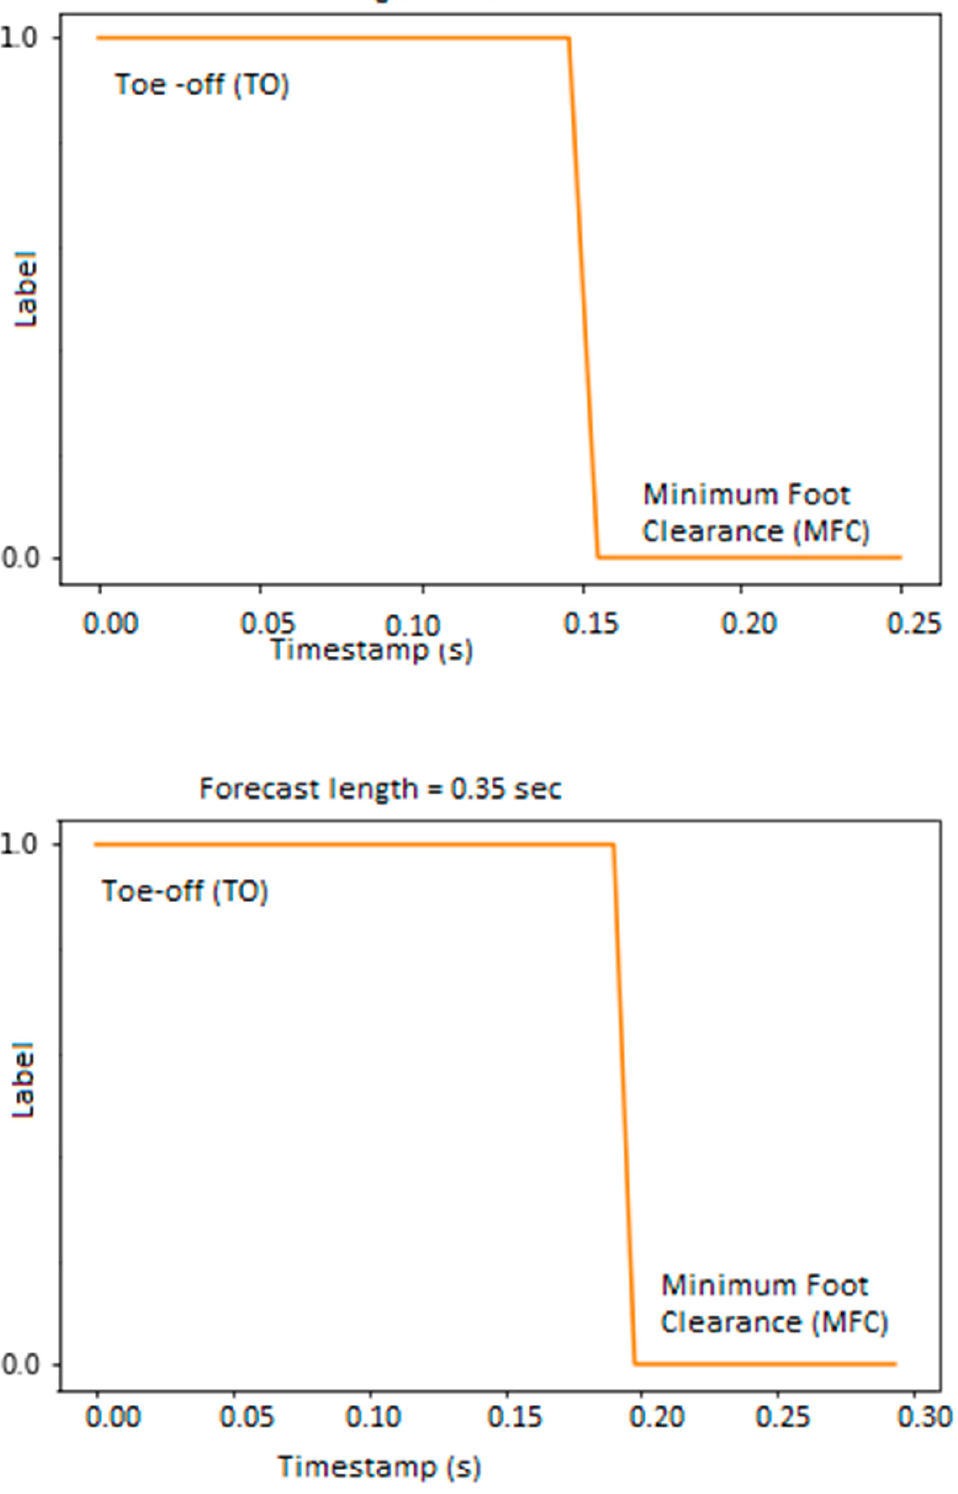
Figure 5. MFC timing forecast from toe-off kinematics at five prediction horizons between 0.15 s and 0.35 s. MFC forecasting diminishes and transitions to a new cycle as the forecast horizon